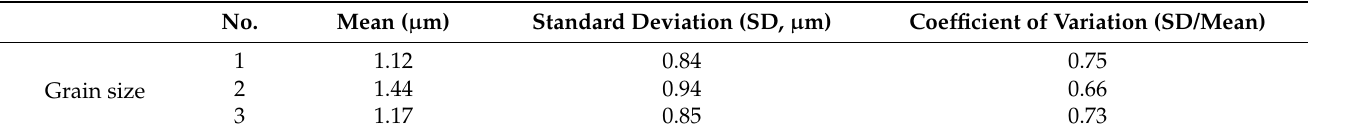
Table 2. The grain sizes of the coating